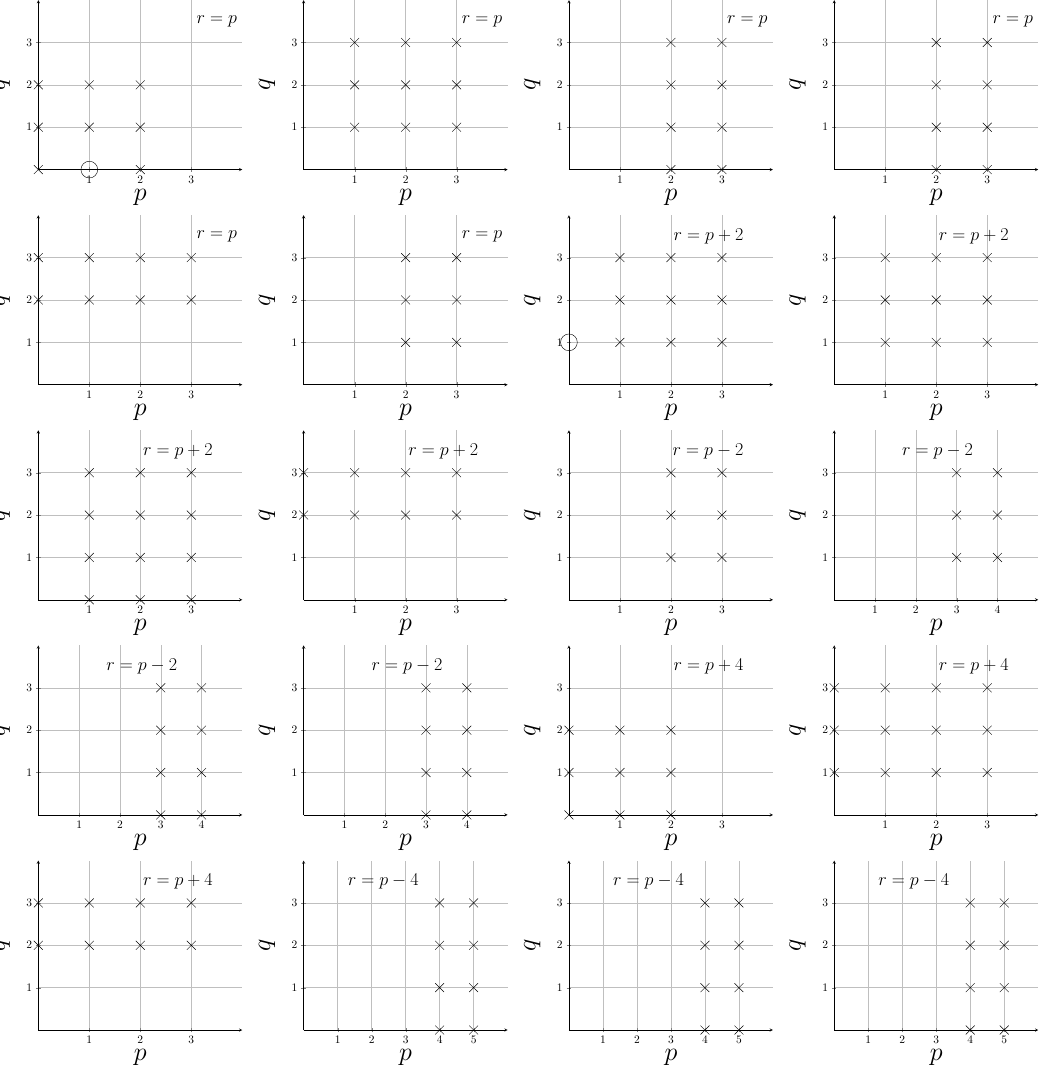
Figure 11. ∆ L (symmetric traceless and transverse rank 2 tensors) towers. The empty circles mark modes which appear from the decomposition of representations of SO(8) on the round sphere, but do not exist when derived in the conventional method. The excess modes are (0 , 1; 2) = ( 5 , 3 ) and (1 , 0; 1) = ( 4 , 2